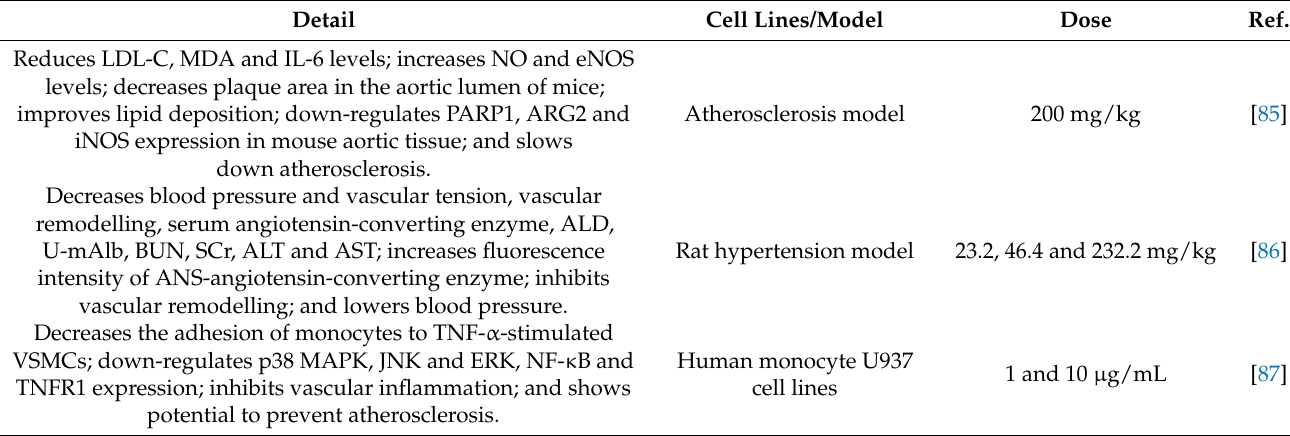
Table 8. Vasoprotective Activity of Hyperoside.